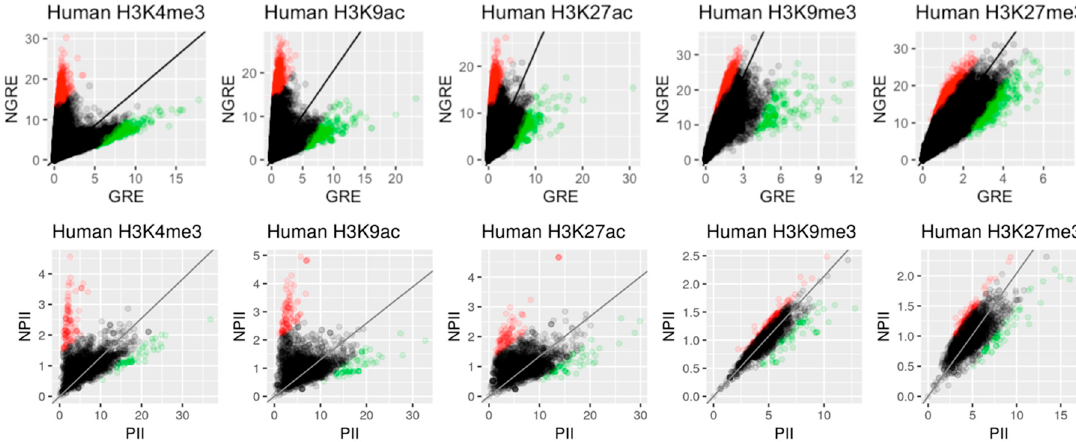
Figure 4. Scatterplots of (NGRE against GRE) and [NPII against PII] for five histone tags in H. sapiens . Each dot represents a single gene. Red and green colours represent genes/pathways enriched and deficient (respectively) for retroelements (RE)-linked epigenetic regulation.